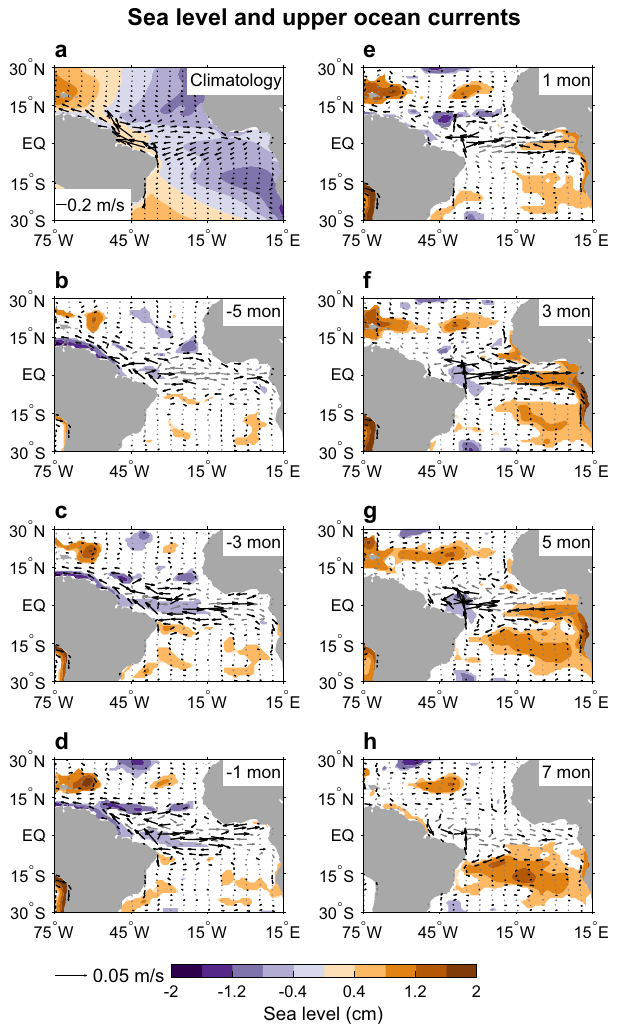
Fig. 3 Sea level and near surface current in the tropical Atlantic Ocean associated with positive IOD. a Annual mean climatology of sea level (cm) and ocean currents averaged over the upper 50 m (m s − 1 ). b – h Lead-lag regression of sea level (shading; cm °C − 1 ) and ocean current anomalies averaged over the upper 50 m (vector; m s − 1 °C − 1 ) from the European Centre for Medium-Range Weather Forecasts (ECMWF) Ocean Reanalysis System 4 (ORAS4) on monthly Dipole Mode Index (DMI). b – h Results for — 5 to 7 months leading time, with negative representing months prior to Indian Ocean Dipole (IOD) peak and positive for after IOD peak. Shading and black vectors represent anomalies that are statistically signi fi cant at the 90% con fi dence